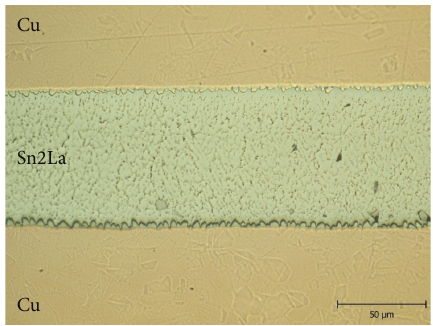
Figure 19: Microstructure of Cu/Sn2La/Cu joint from the light optical